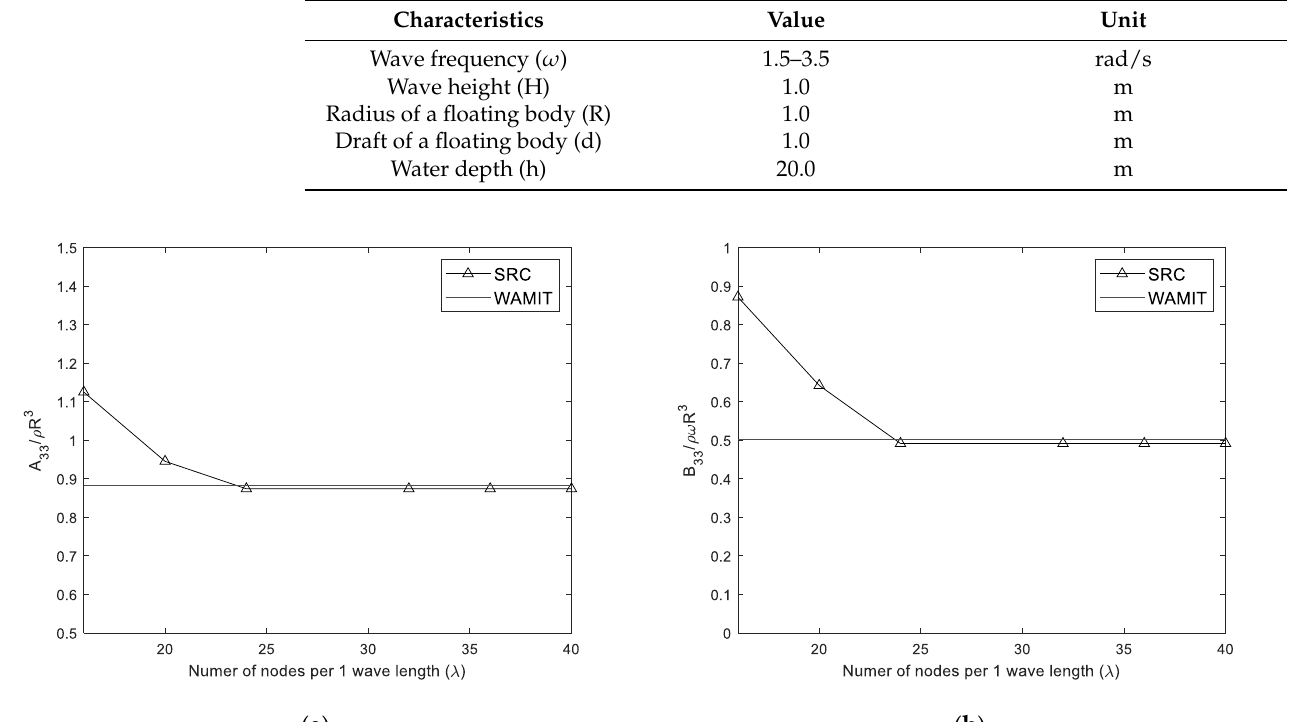
Table 1. Calculation conditions for Sommerfeld radiation condition.